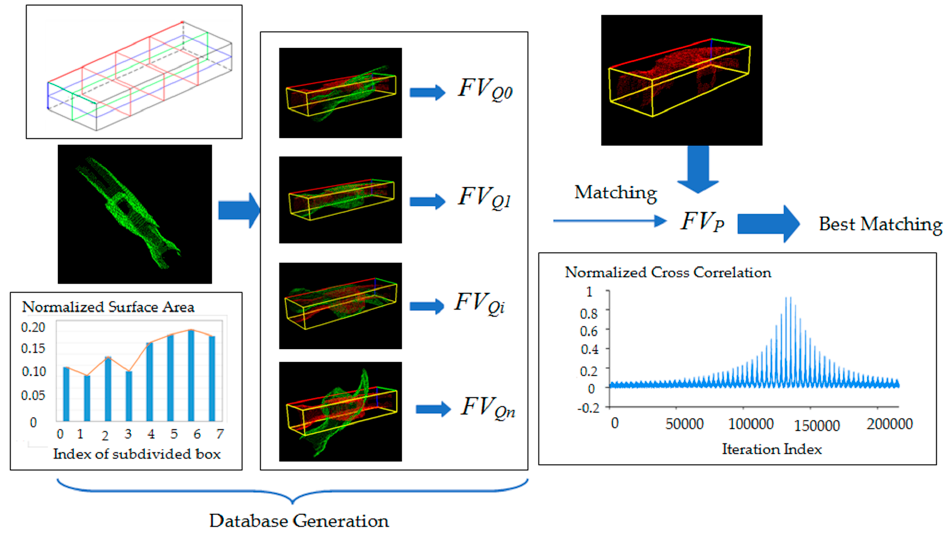
Figure 2. The proposed registration method based on the OBB (oriented bounding box) regional area ‐ based descriptor.